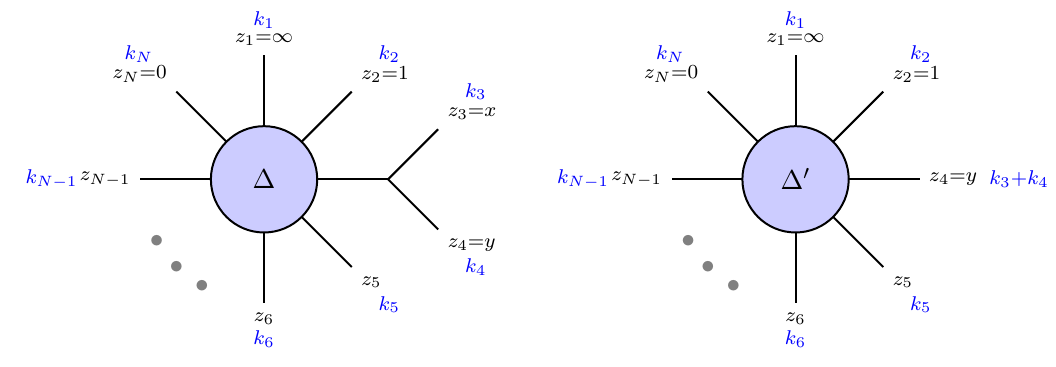
Figure 3 . Feynman diagrams (cid:1) and (cid:1) 0